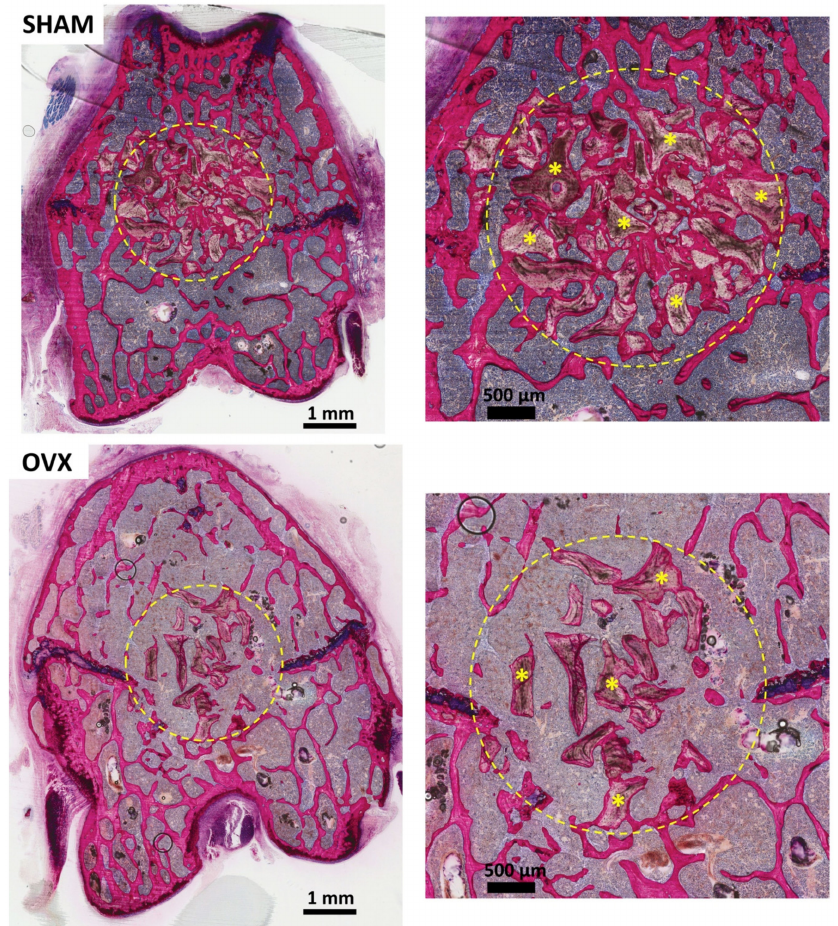
Figure 4. Representative histological images of pMMA sections: ( left ) for SHAM and OVX at 14 weeks post-implantation; and corresponding images at × 20 magnification ( right ). Methylene blue and basic fuchsin staining was performed. Within the ROI, images show the evident presence of new bone, remaining InterOss ® material (yellow*) and trabecular bone space